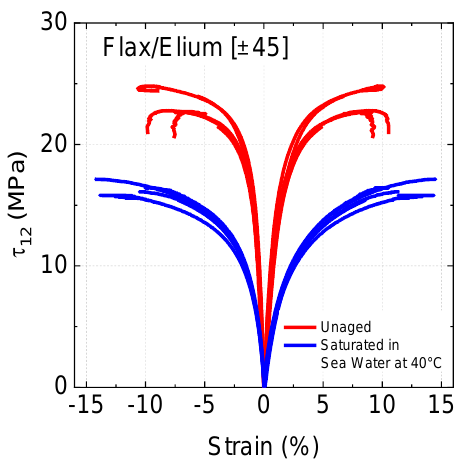
Fig.5. Test results for ±45° specimens, tested dry and seawater saturated.